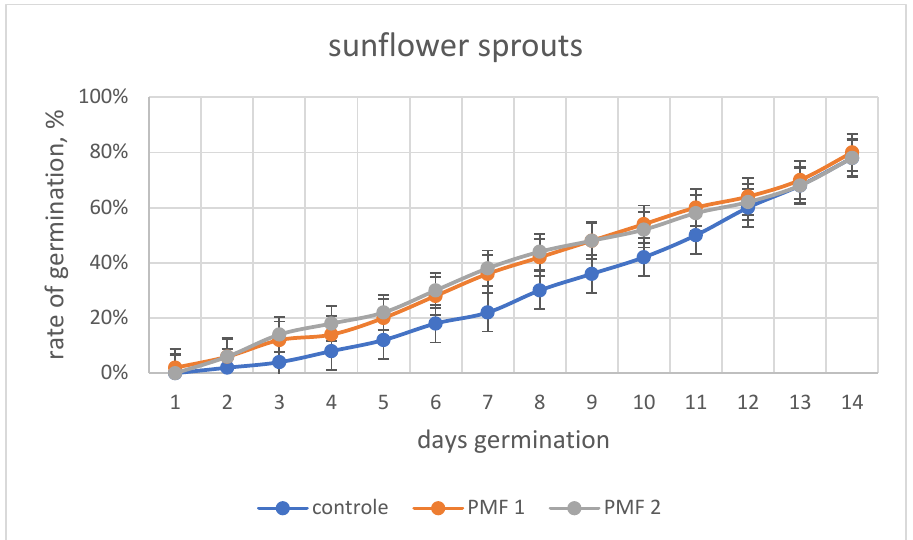
Figure 4. Sunflower sprout germination dynamics for the control sample and for magnetic field 1 (PMF 1 – 100 µT and 100 Hz) and magnetic field 2 (PMF 2 – 100 µT and 200 Hz), mean standard error α = 0.05.